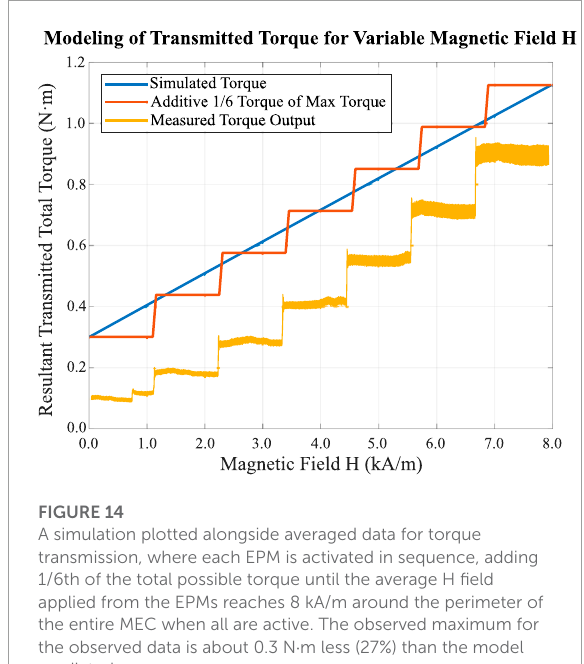
FIGURE 14 A simulation plotted alongside averaged data for torque transmission, where each EPM is activated in sequence, adding 1/6th of the total possible torque until the average H field applied from the EPMs reaches 8 kA/m around the perimeter of the entire MEC when all are active. The observed maximum for the observed data is about 0.3 N ⋅ m less (27%) than the model